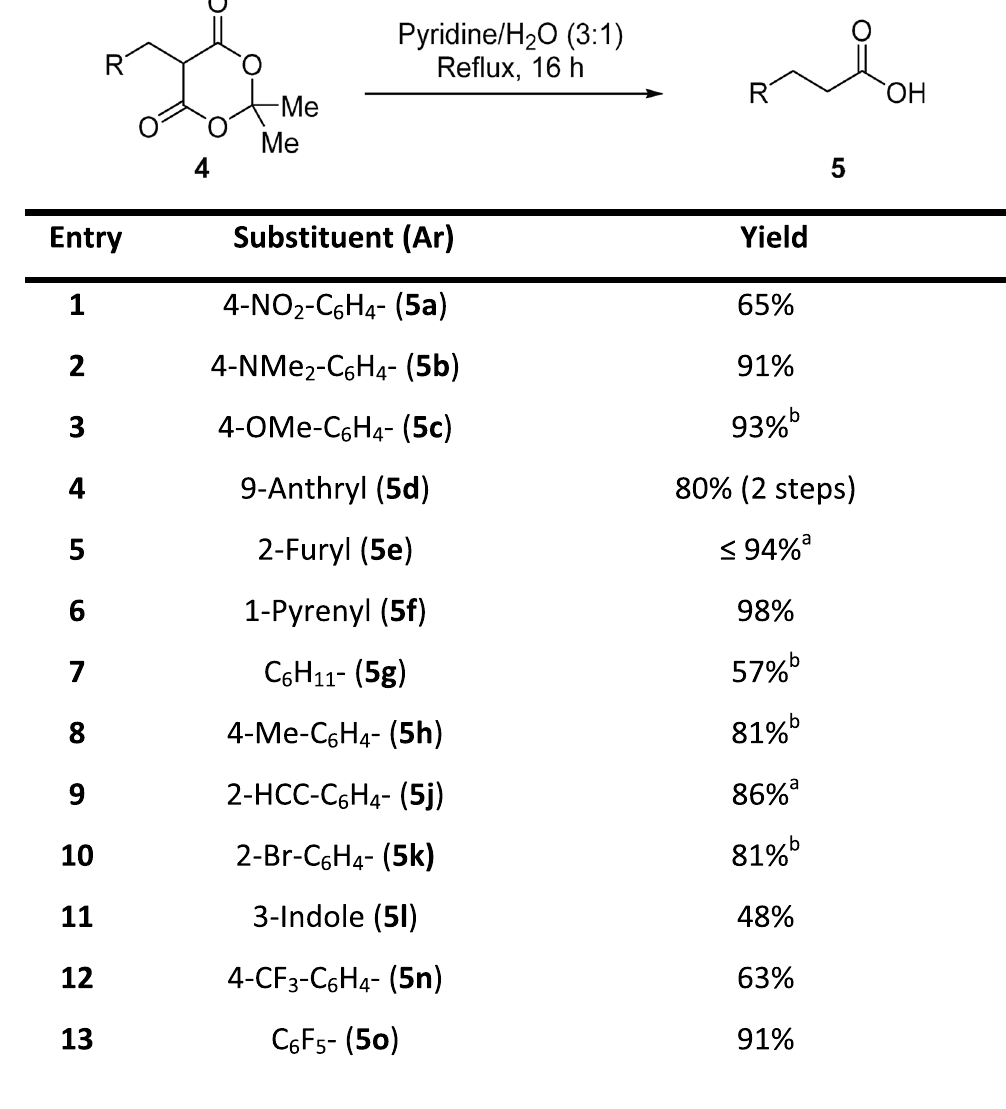
Figure 4. Decarboxylation to synthesise hydrocinnamic acid